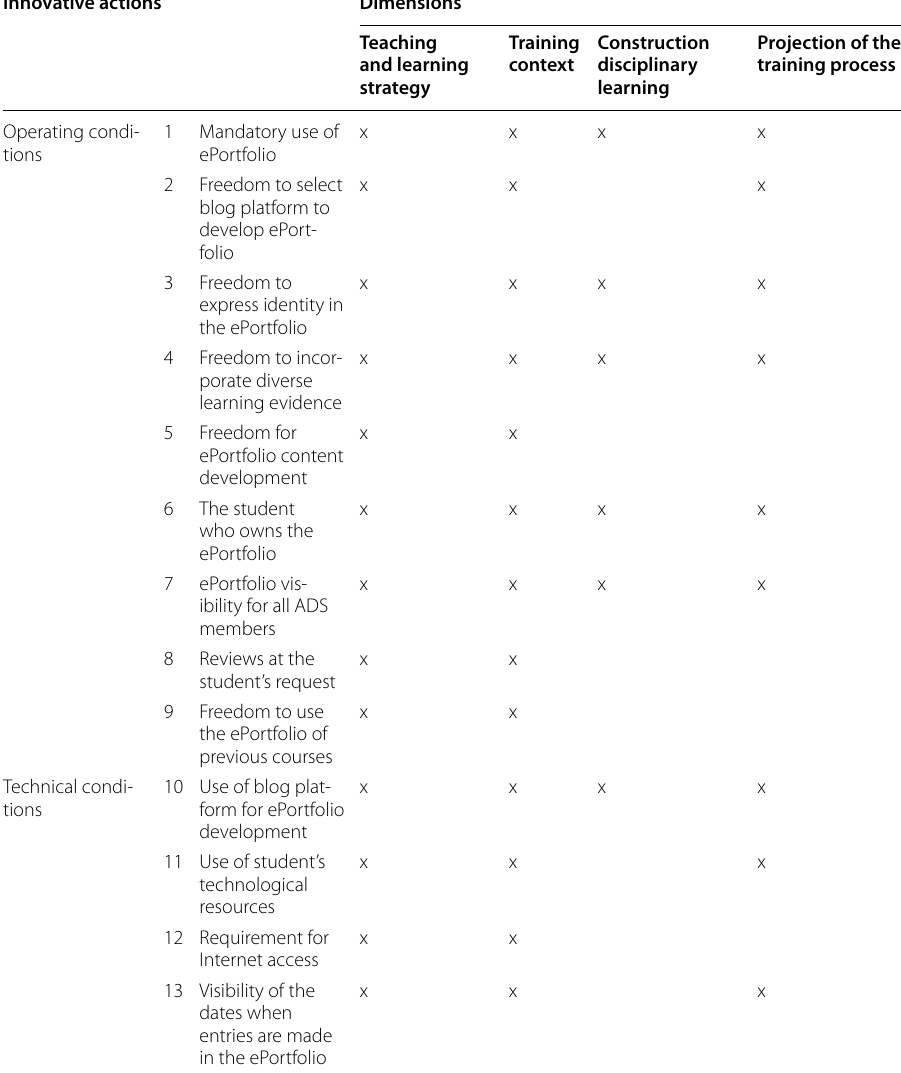
Table 2 Summary of innovative actions and their relationship with the training process dimensions in ADS (adapted from Shulman) Innovative